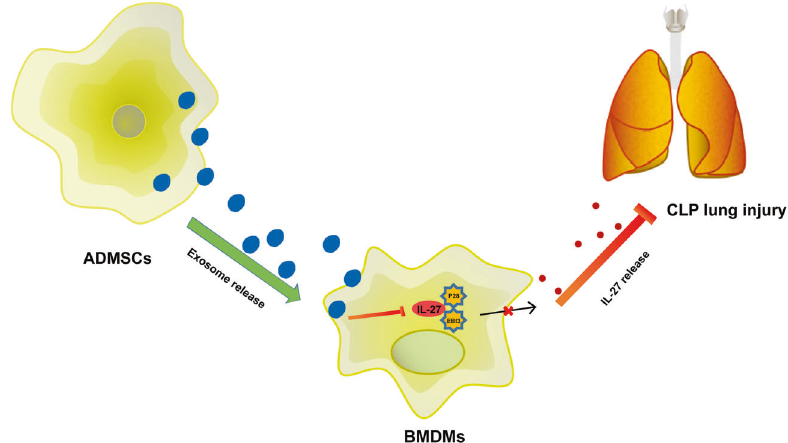
Fig. 6 Mechanism diagram. ADMSC-exosomes inhibited IL-27 secretion in macrophages, thereby delaying sepsis-induced lung injury in